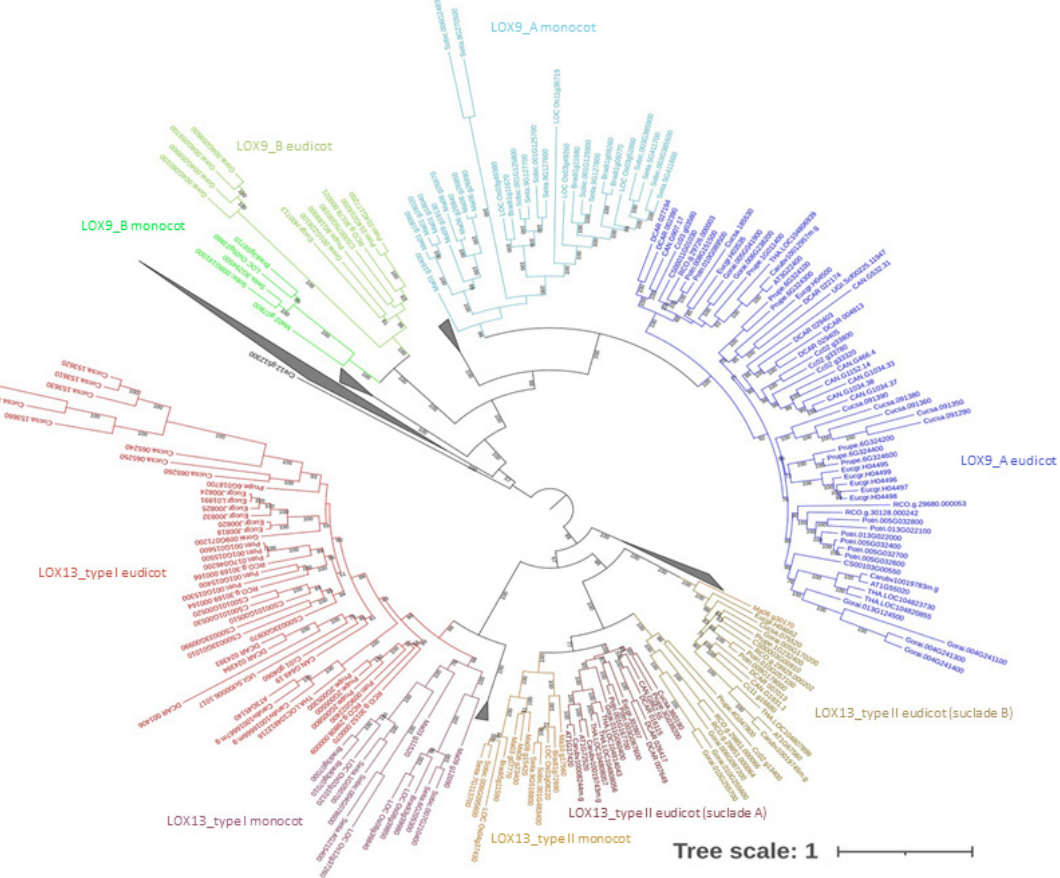
Figure 2. Evolutionary tree (maximum likelihood method, 1000 replicates per bootstrap) of lipoxygenases from 23 plant species. To facilitate visualization, we included the name of each clade with its corresponding color. Legend: eudicot LOX13_type I is in light-red, monocot LOX13_type I is in light-purple, monocot LOX13_type II is in light-brown, eudicot LOX13_type II (subclade A) is in dark-purple, and eudicot LOX13_type II (subclade B) is represented in dark-brown color. The LOX9_A group’s respective division among angiosperms is represented with the following colors: eudicot LOX9_A—dark blue and monocot LOX9_A—light blue. The LOX9_B group is represented in two shades of green: eudicot LOX9_B—dark green and monocot LOX9_B—light green.